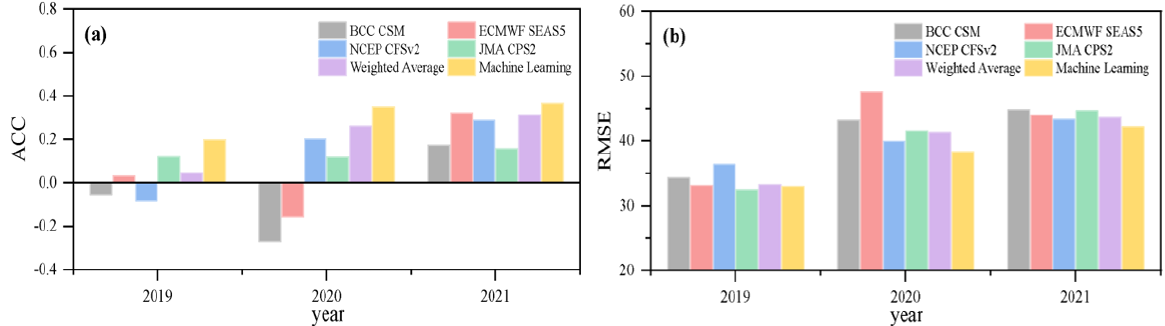
Figure 10. Comparison of the prediction accuracy among the four models, weighted average MME and ML-based MME: ( a ) ACC, ( b ) RMSE.